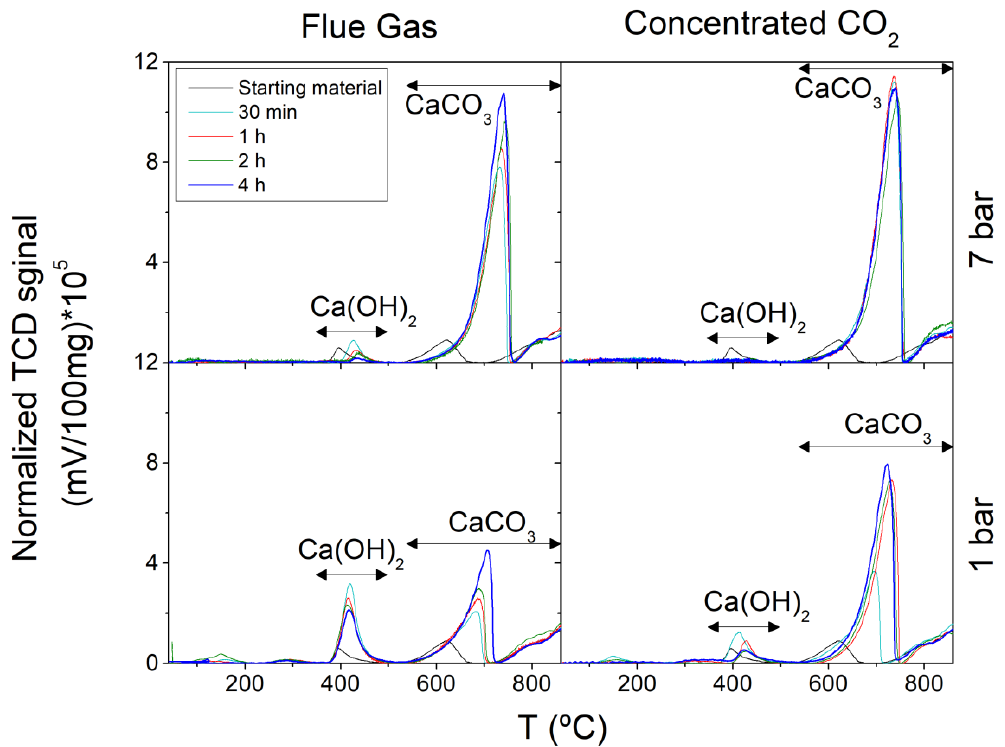
Figure 4. TPD results of the starting and carbonated